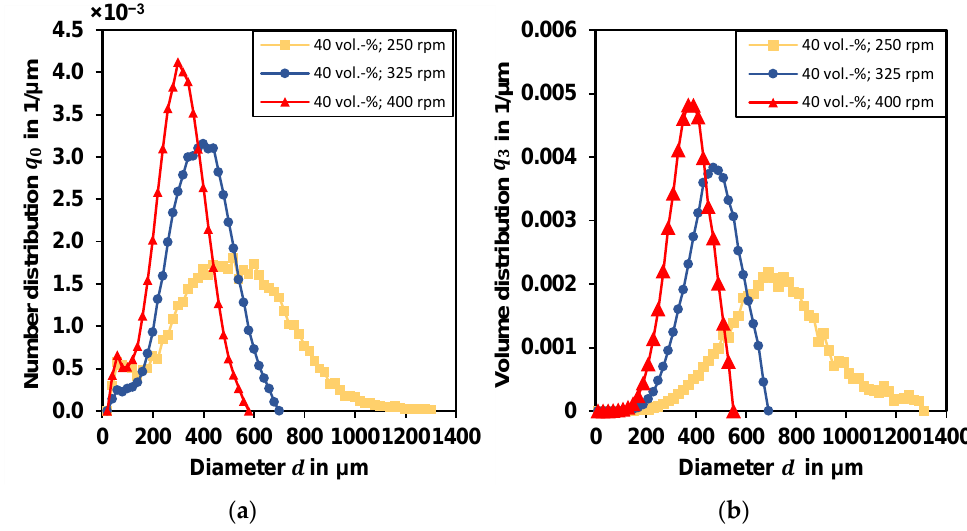
Figure 5. ( a ) Number distribution at different rpm at 𝜑 = 40 vol.-% phase fraction; ( b ) volume distribution at different rpm at 𝜑 = 40 vol.-% phase fraction. The lines are a guide to the eye.